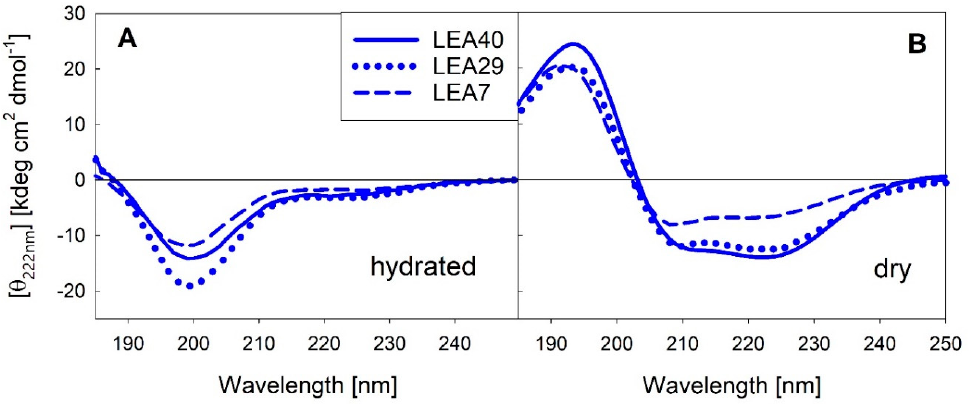
Figure 5. Far-UV circular dichroism (CD) spectra of the three LEA_7 clade proteins in the fully hydrated state (A) and after drying (B). All spectra were averaged over at least three replicates per